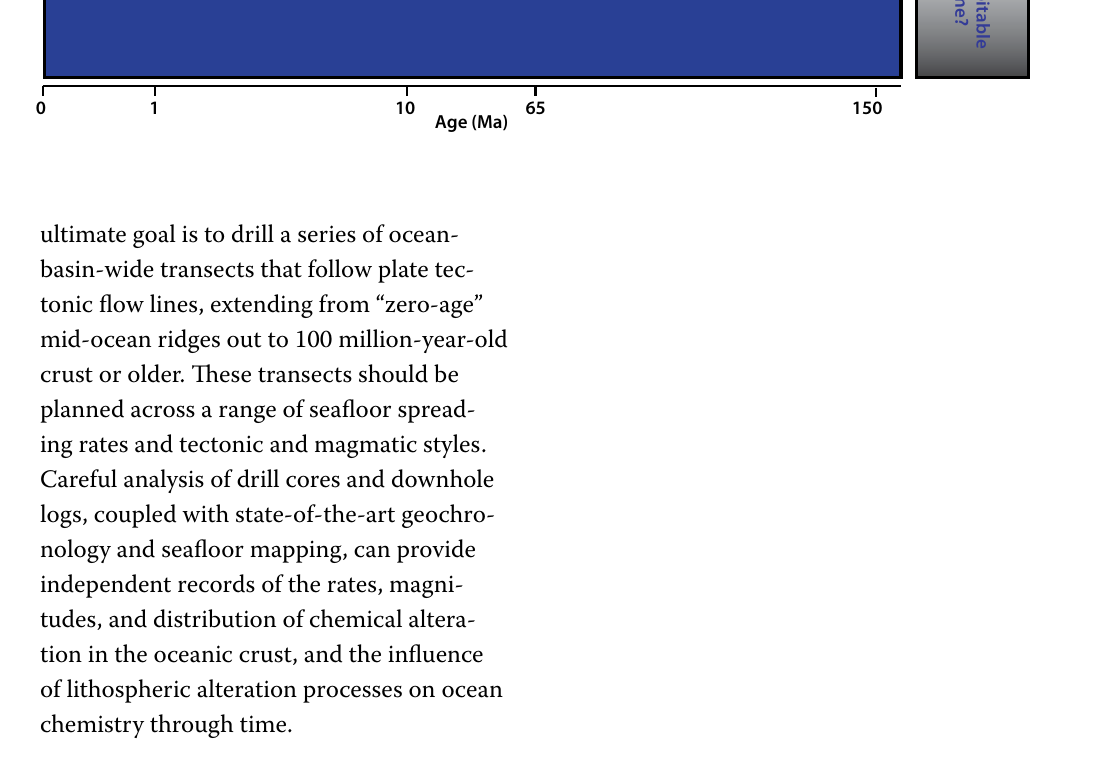
figure 4.7. schematic archi- tecture of a mid-ocean ridge flank (not to scale) illustrating the parameters that may influ- ence the intensity and style of hydrothermal circulation, such as faults, seamounts, basement topography, and impermeable sediments that isolate the crust from the ocean. arrows indicate heat (red) and fluid (blue) flow. The yellow dashed line is a hypothetical trajectory of the 120°c isotherm as oceanic crust moves away from the ridge crest. modified from a figure provided by r. coggon, imperial college london, d. Teagle, University of southampton, and K. nakamura,